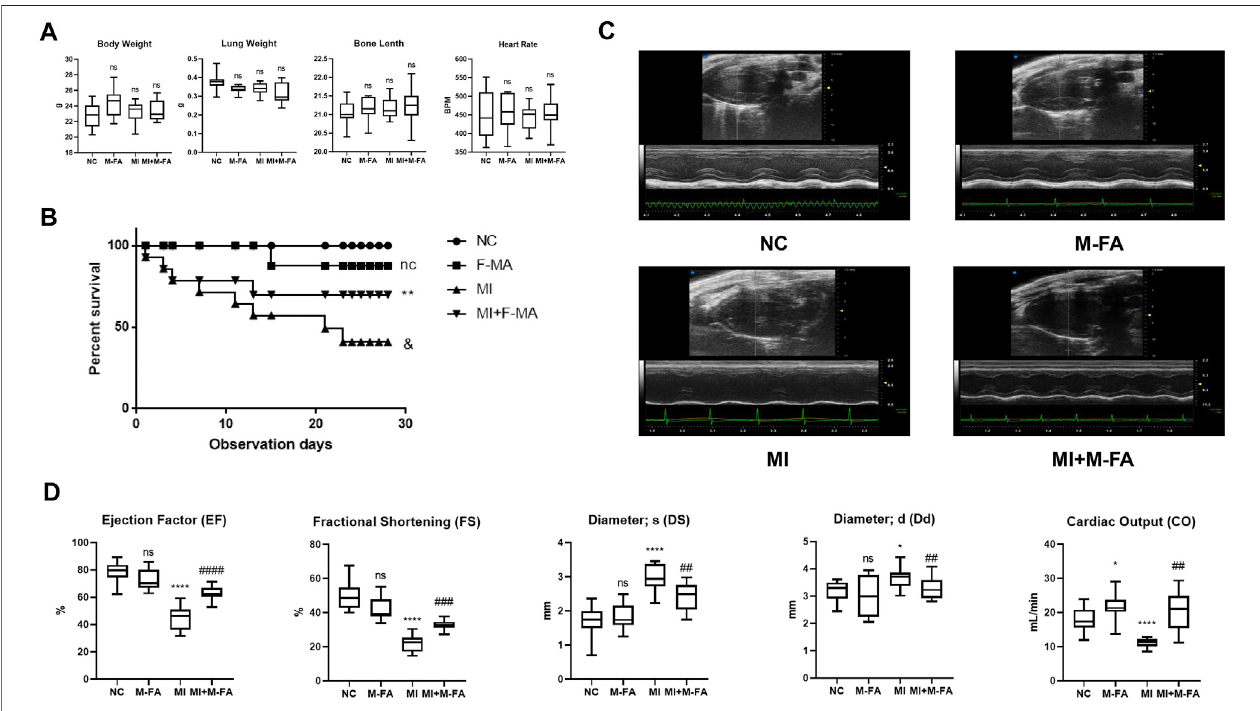
FIGURE 4 | MFA improved the survival and cardiac function in MI mice. (A) General indicator among four groups of mice ( n (cid:2) 6). (B) K-M analysis among four groupsofmice(n (cid:2) 15). (C – D) Echocardiographyimages(inbothBandMmode)(C),andcardiacfunctionsamongfourgroupsofmice( n (cid:2) 6).(*comparedwithnegative control: * p < 0.05, ** p < 0.01, **** p < 0.001. # Compared with the MI group: # p < 0.05, ## p < 0.01, ### p < 0.005, #### p <